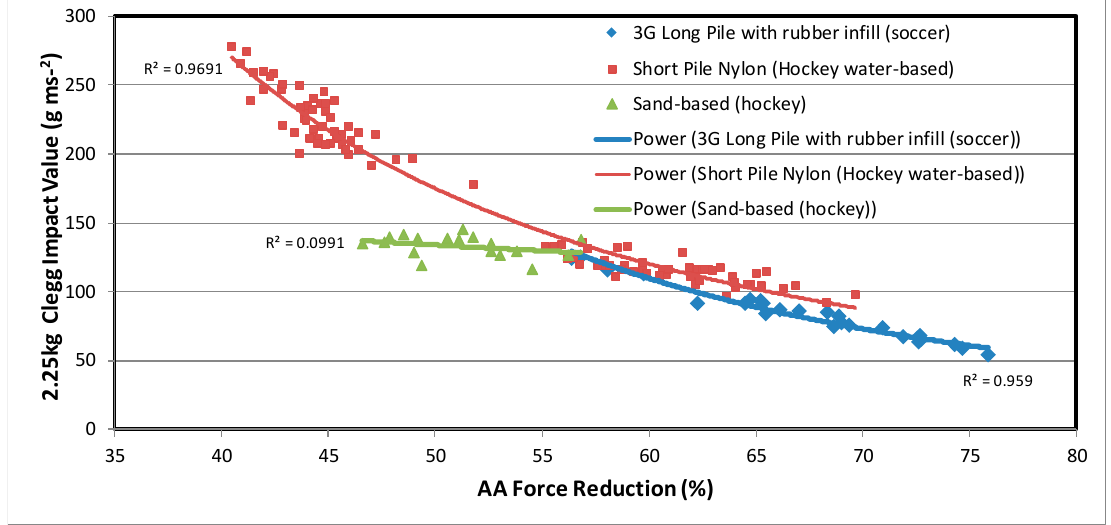
Figure 3. The relationship between the industry standard AAA and the 2.25 kg Clegg Hammer for three different generic types sport surface systems (modified from